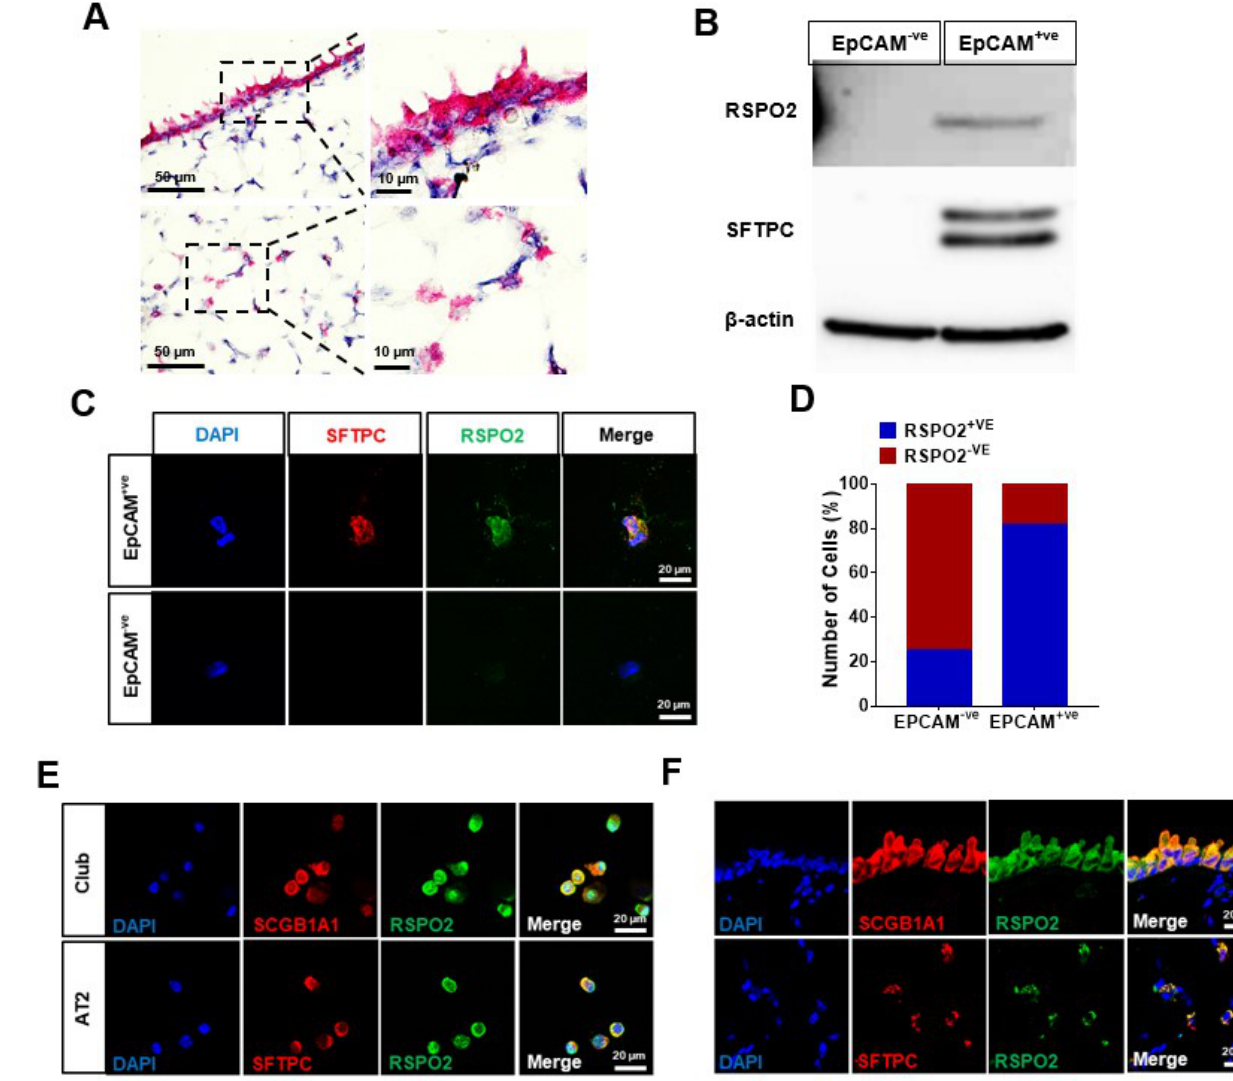
Figure 1. RSPO2 is expressed in club and AT2 cells of adult lungs. ( A ) Single-molecule RNA in situ hybridization detection of Rspo2 RNA. Top and bottom panels represent the airway and alveoli, respectively. The right panels show the magnified images of the dotted rectangular region of the left panels. ( B ) Western blot analysis of RSPO2 protein expression in freshly isolated EpCAM +ve distal lung epithelial cells. SFTPC and β -actin expression were also determined for validating cell purity and as protein loading control, respectively. ( C ) Immunofluorescence staining of RSPO2 (green) and AT2 cell marker, SFTPC (red), in freshly isolated EpCAM +ve distal lung epithelial cells. ( D ) Quantification of RSPO2 +ve cell fraction in the isolated distal lung epithelial cells. ( E ) Co-expression of RSPO2 (green) and club cell marker, SCGB1A1 (red), in the isolated club cells, and RSPO2 (green) and SFTPC (red) in AT2 cells. ( F ) Immunofluorescence staining of RSPO2 (green), SCGB1A1 (red in the upper panels), and SFTPC (red in the bottom panels) in adult lung tissue section.